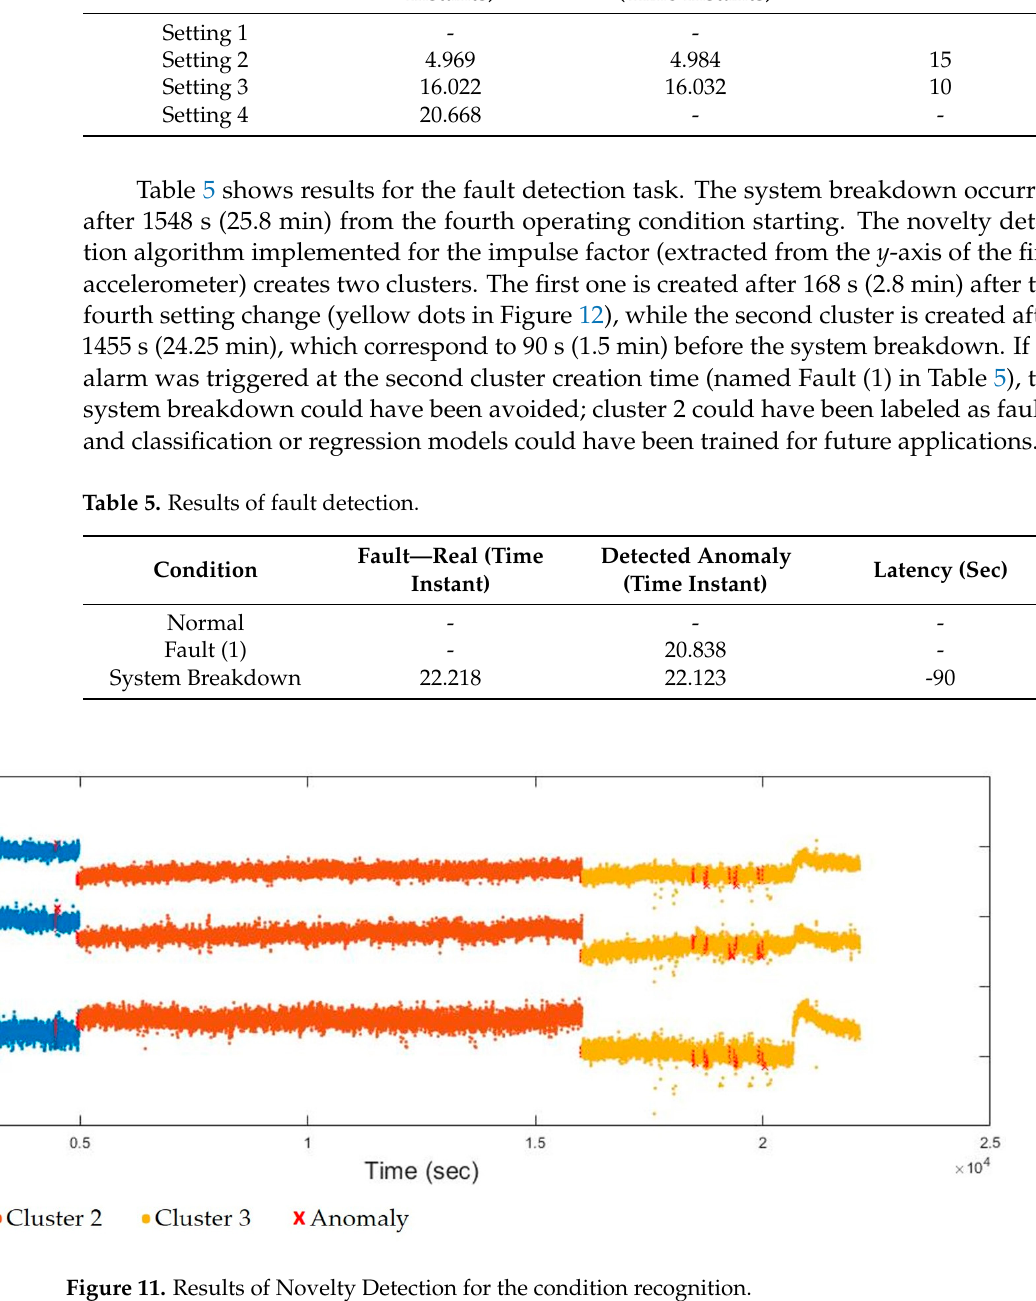
Figure 11. Results of Novelty Detection for the condition